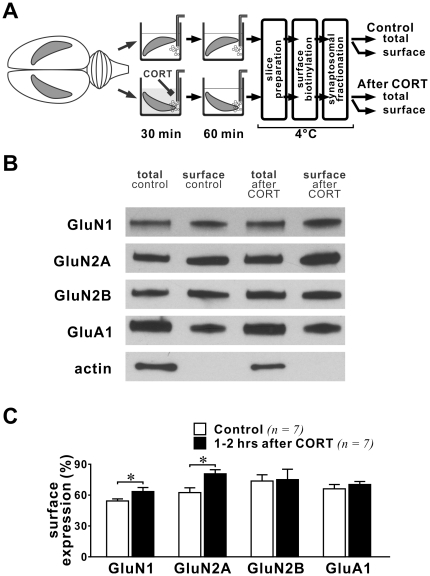
Trafficking of glutamate receptors in adult hippocampal synapses 1–2 hours after CORT treatment.(A) Schematic diagram shows procedures for drug treatment and tissue labeling. Note that unlike
Figure 4
, hippocampi were incubated in aCSF for 1–2 hours after CORT treatment before labeling. (B) Representative blots of different glutamate receptor subunits and actin in synaptosomal membranes from control and CORT-treated hippocampi of the same rat. (C) Histogram summarizes the surface expression of glutamate receptors (ratio of surface/total) in control and CORT-treated hippocampi. Note that the surface expression of both GluN1 and GluN2A was increased by CORT at this time window. * p<0.05; paired student's t-test (control vs. CORT-treated hippocampi from the same rat).